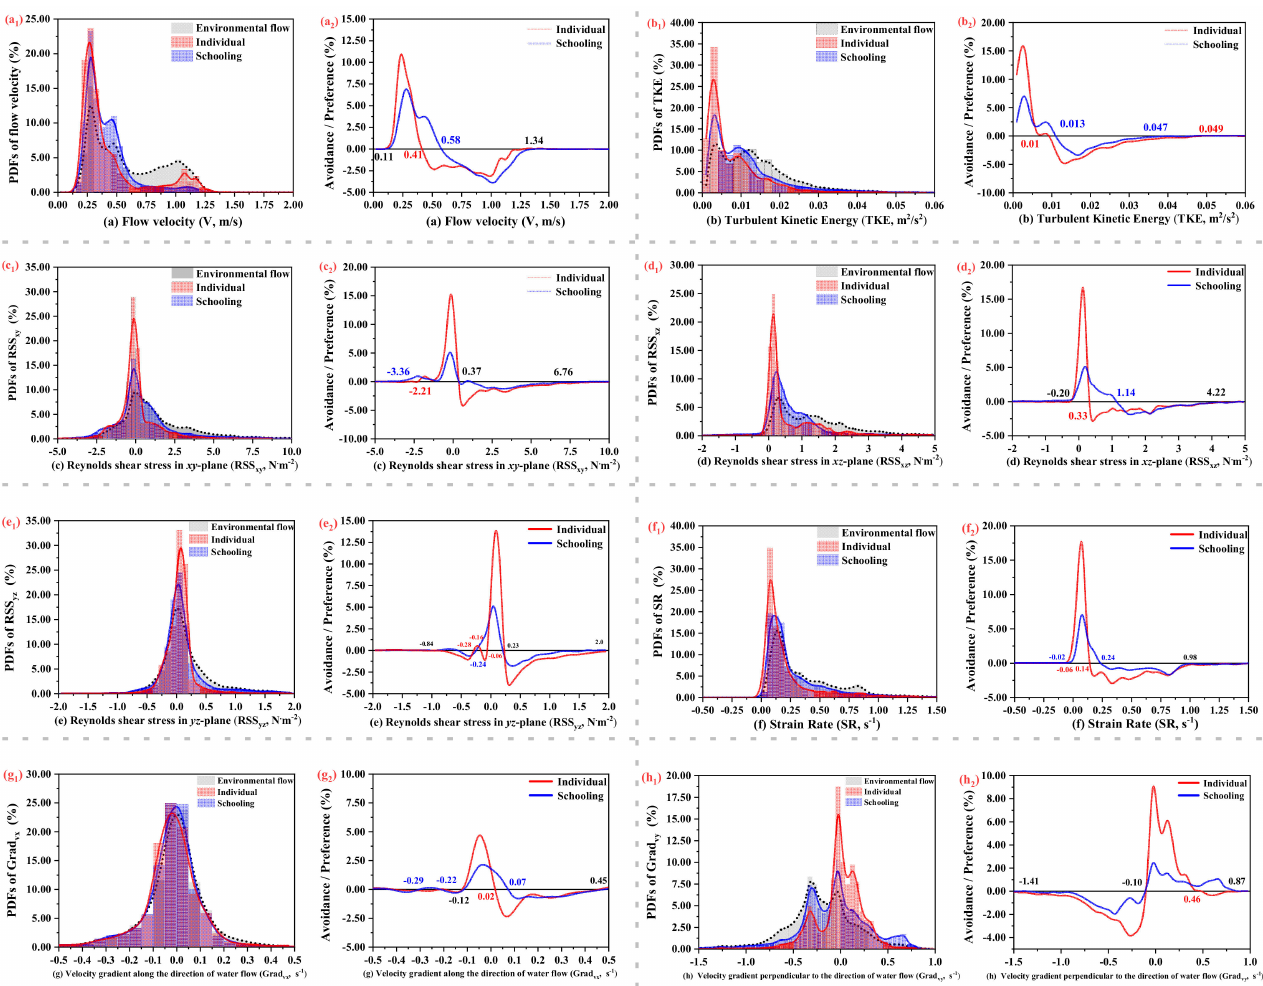
Figure 10. The preference and avoidance behaviors of fish to different hydraulic parameters during upstream migration: ( a ) flow velocity (m/s); ( b ) turbulent kinetic energy (TKE, m 2 · s − 2 ); Reynolds shear stress in three planes: ( c ) RSS xy , ( d ) RSS xz , and ( e ) RSS yz , N . m − 2 ; ( f ) strain rate (SR, s − 1 ); and ( g ) velocity gradient along (Grad vx , s − 1 ) and ( h ) perpendicular to the direction of water flow (Grad vy , s − 1